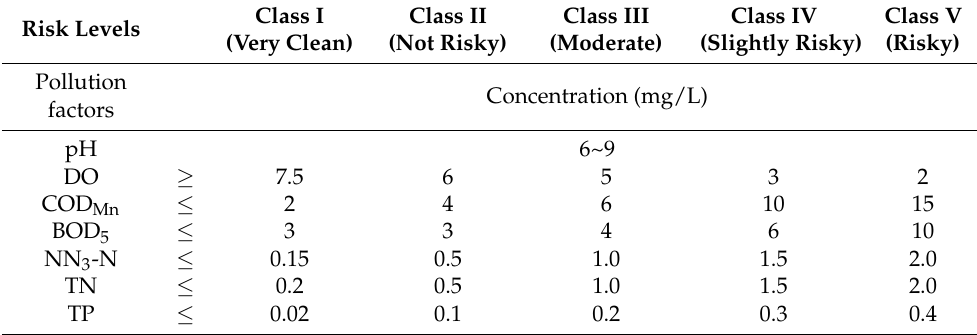
Table 3. Environment quality standards for surface water.